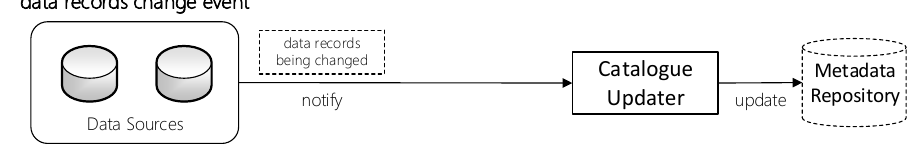
Figure 2. Event-based catalogue update.